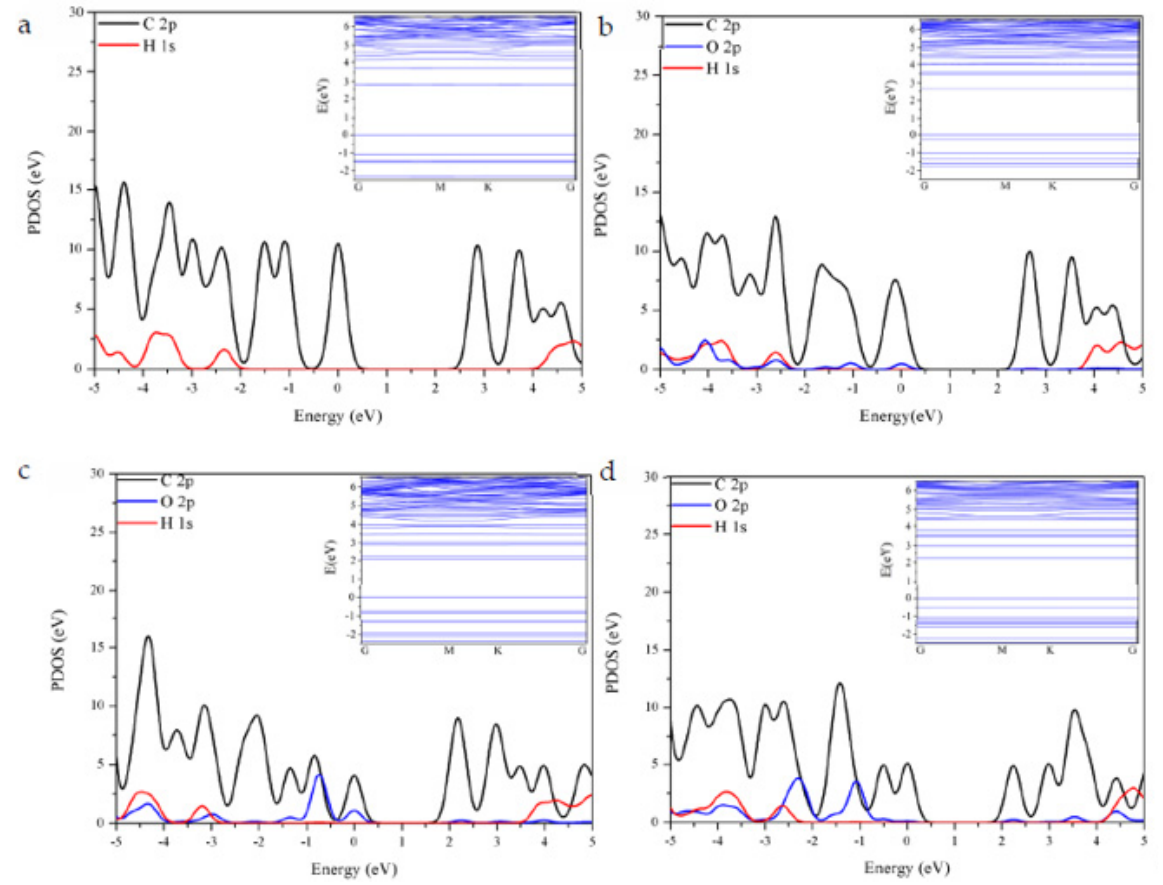
Figure 3. Partial density of states (PDOS) of pure CDs ( a ), CDs-T (T is hydroxyl ( b ), carbonyl ( c ), and carboxyl ( d )); the insets in these figures are the corresponding band structures. The PDOS and band structure of MoS 2 /CDs and MoS 2 /CDs-T heterostructures are shown in Figure 4. In the LUMO, the conduction bands of these heterostructures are mainly hybridized from Mo 4d and S 3p orbitals. There are energy levels under the Femi level. For MoS 2 /CDs, MoS 2 /CDs-OH, and COOH, these energy levels are mainly composed of the C 2p orbital. However, the energy level at the Femi level of MoS 2 /CDs-O is hybridized from the C 2p and O 2p orbitals. The electronic structure indicates that the Mo 4d, S 3p, C 2p, and O 2p orbitals are the main way of photo-induced electron. Under the illumination,